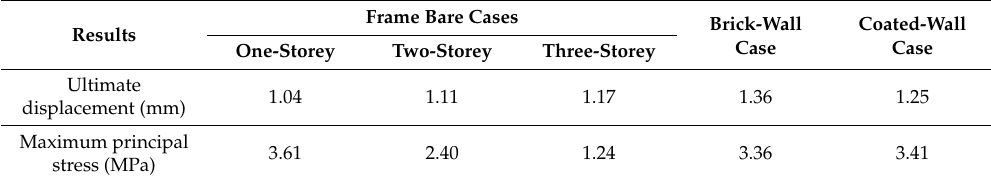
Table 6. The ultimate displacement and principal stress values.